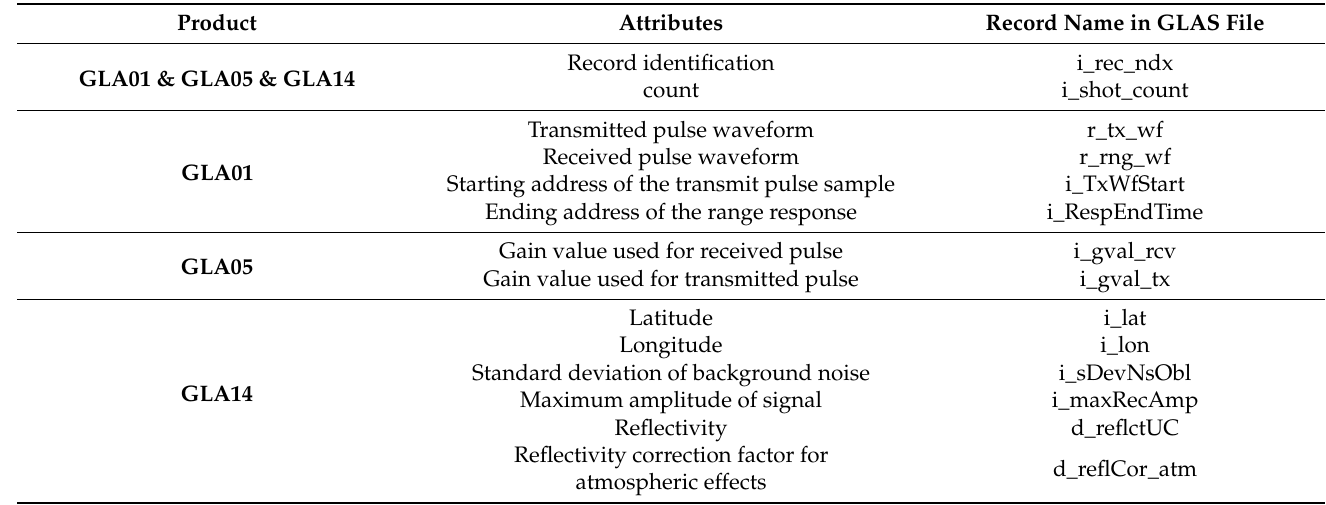
Table 1. Key information extracted from GLAS products.